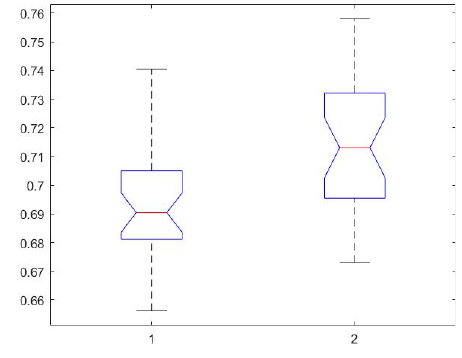
Figure 17. ANOVA test, F 1 indicator. 3. POCID indicator. The result indicates a dissimilarity between the POCID values, the one corresponding to the proposed method being significantly better.